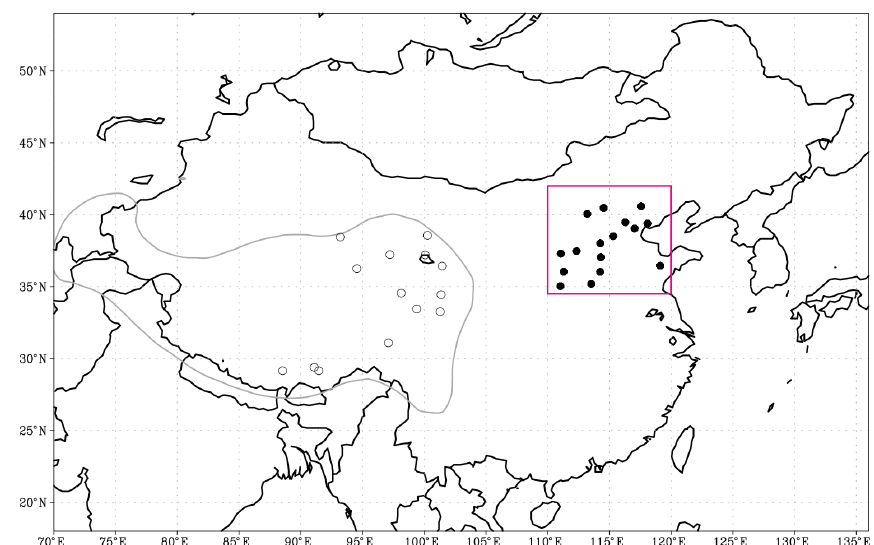
Figure 3. Geographical distribution of stations with complete soil temperature records for all nine soil layers for 1981–2005. The red boxed region is North China (110–120 ◦ E, 34.5–42 ◦ N), and the locations of the 16 sites used in this study are marked by solid circles. The grey line shows that the elevation is above 2500m, and the grey empty circles denote the locations of the 14 sites on the